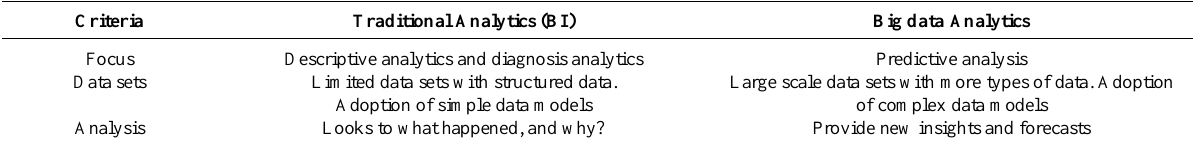
Table 1. Traditional Analytics (BI) vs. Big Data Analytics.